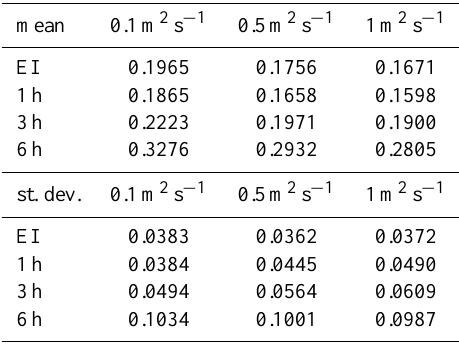
Table 1. Mean values and standard deviation along the studied pe- riod of the integrated difference between reconstructions and obser- vations for each D and wind set: EI, 1h, 3h, and 6h correspond to ERA Interim, one hourly, three hourly and six hourly winds respec- tively. Units in ppmv of